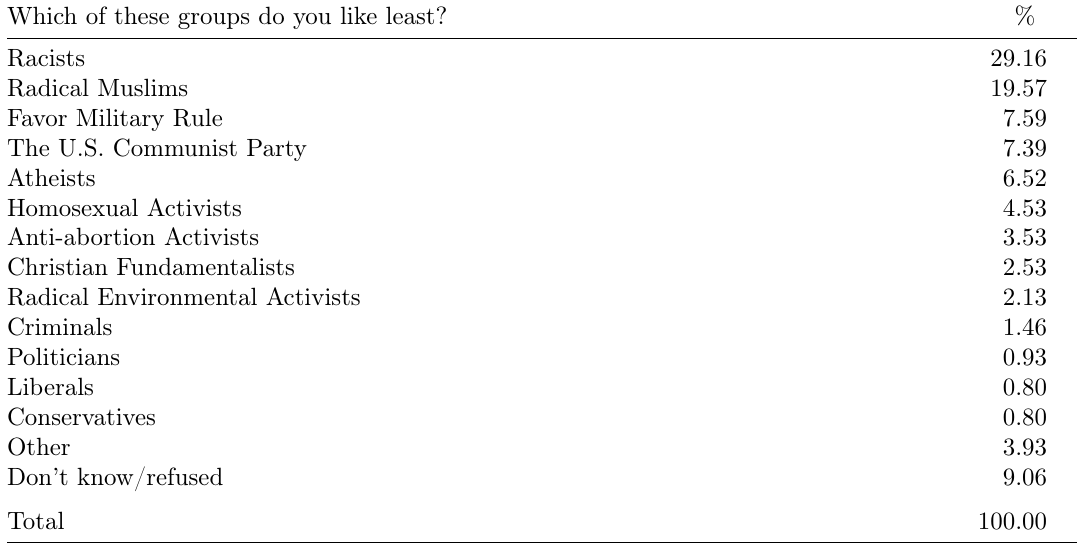
Table 1: Descriptive Statistics for Least Liked Groups Which of these groups do you like